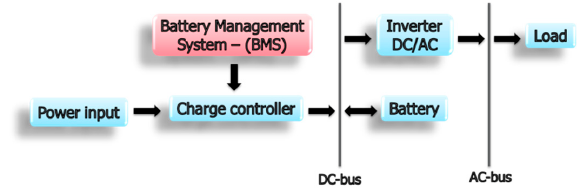
Figure 2. Battery control scheme.